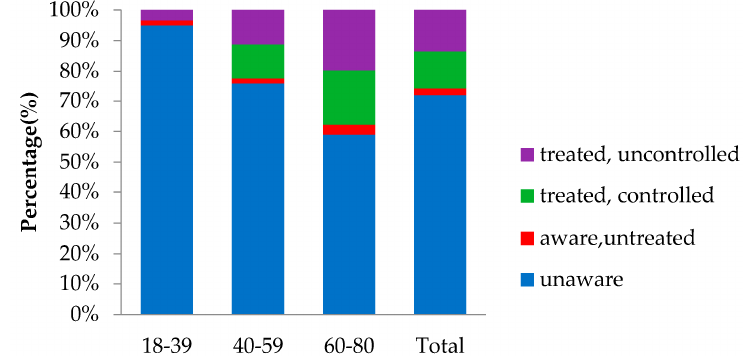
Figure 2. Age- and Sex-Standardized Rates of Awareness, Treatment, and Control of diabetes mellitus.